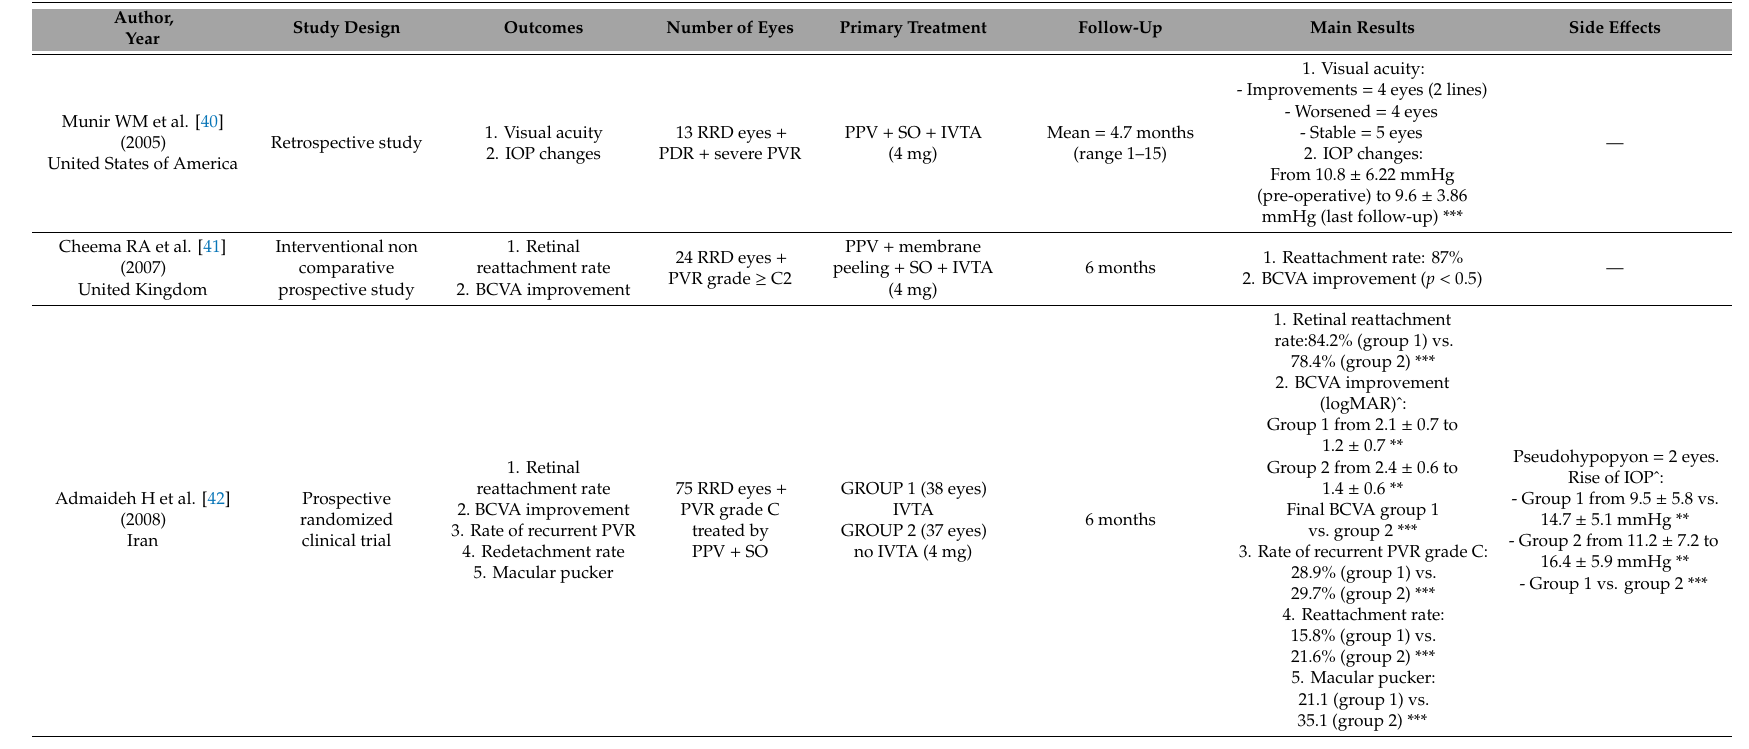
Table 2. Intraoperative use of corticosteroid drugs in retinal detachment